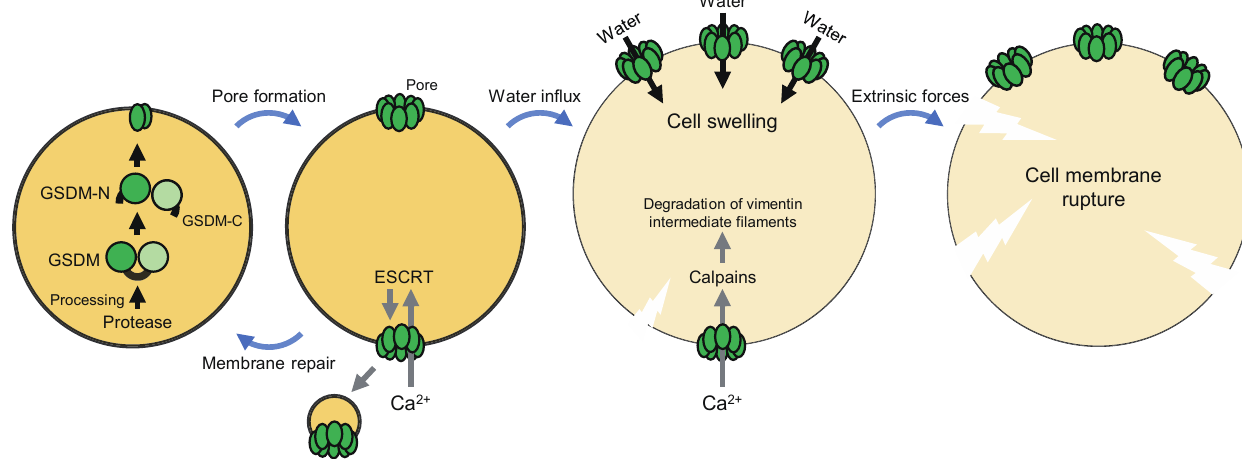
Figure 1. The molecular mechanism of pyroptosis. Pyroptosis is a necrotic form of regulated cell death executed by gasdermin (GSDM) family members. GSDMs, which are expressed as inactive forms, are proteolytically activated by certain proteases. The N -terminal fragments of GSDMs form pores in the plasma membrane. These pores cause water influx driven by osmotic pressure, leading to cell swelling and ultimately plasma membrane rupture. GSDM pores also allow the influx of Ca 2+ , which directs the assembly of the endosomal sorting complex required for transport (ESCRT) machinery. The ESCRT machinery mediates plasma membrane repair by promoting budding and pinching off of the damaged membrane. Calpains are also activated, which in turn degrade vimentin intermediate filaments, thereby enhancing rupture of the plasma membrane by extrinsic forces.